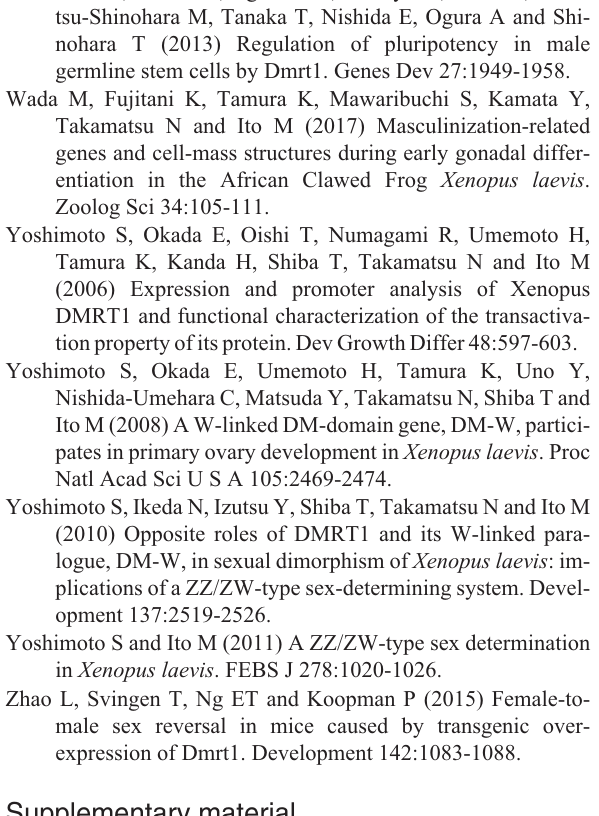
Table S1 - Sequences of oligonucleotide primers used in PCR reaction for